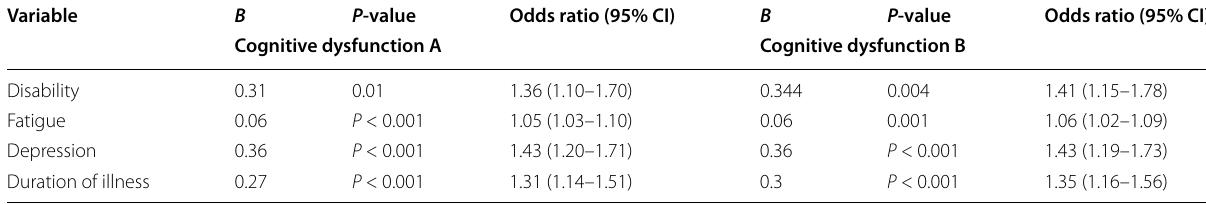
A Cognitive dysfunction without adjustment = B Cognitive dysfunction with adjustment of age, gender, and education